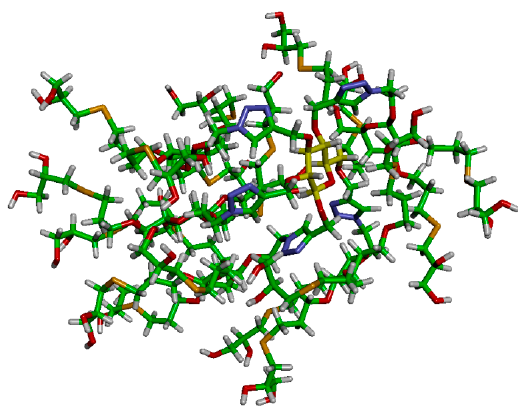
Figure 3. Stick representation of dendrimer 16 after equilibration by MD simulation (water molecules not shown).